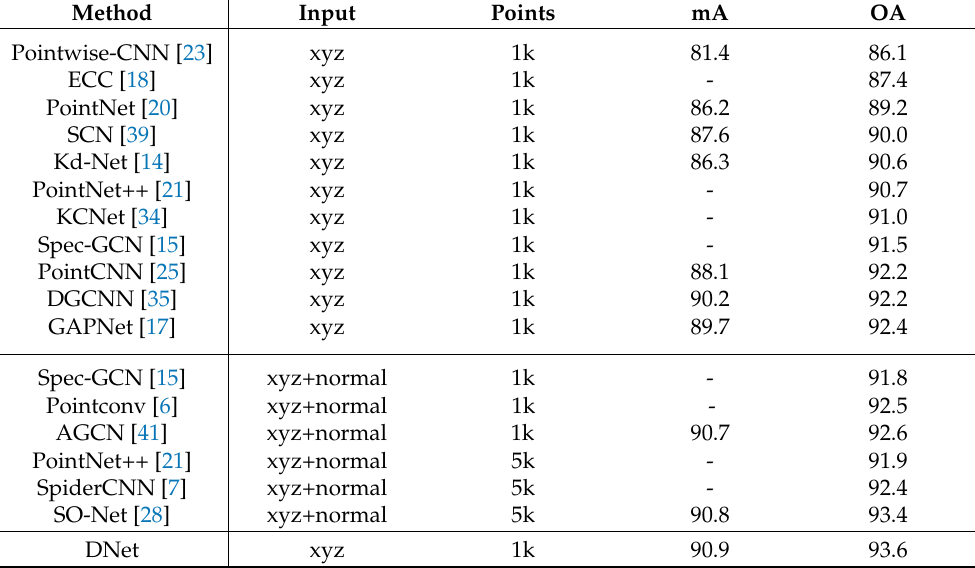
Table 1. Classification accuracy of different networks (%). (mA and OA denote the mean accuracy of each class of point cloud classification and the overall accuracy of point cloud classification,